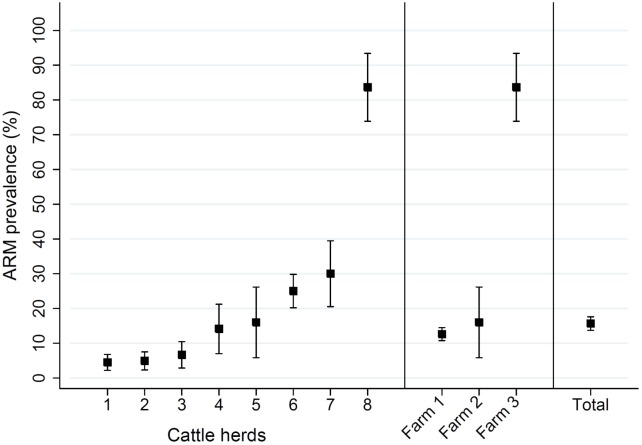
Cefotaxime resistance in cattle.The prevalence of cefotaxime resistant bacteria isolated from eight cattle herds housed at three farms located in North-Central Florida is presented with 95% confidence intervals, along with the total prevalence. Farm 1 includes herds of 1, 2, 3, 4, 6, and 7. Farm 2 and 3 include herd 5 and 8, respectively.